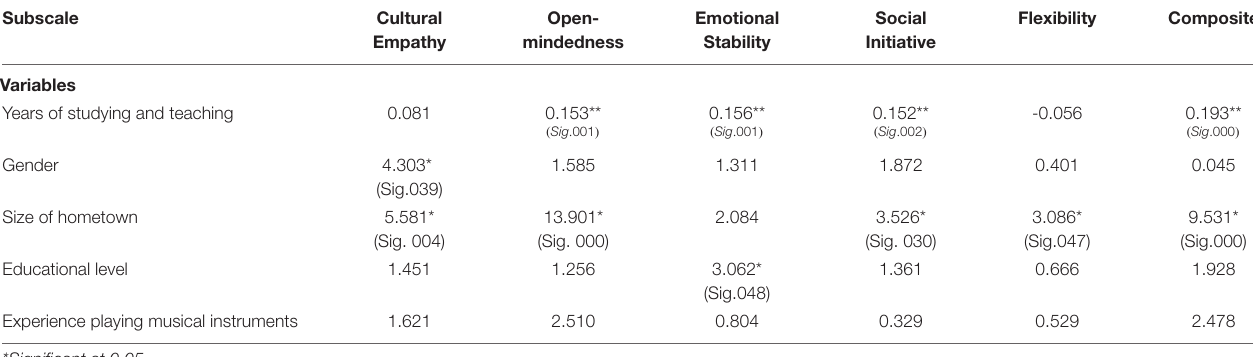
TABLE 2 | Preservice music teachers’ demographic characteristic correlations with multicultural personality questionnaire-short form.